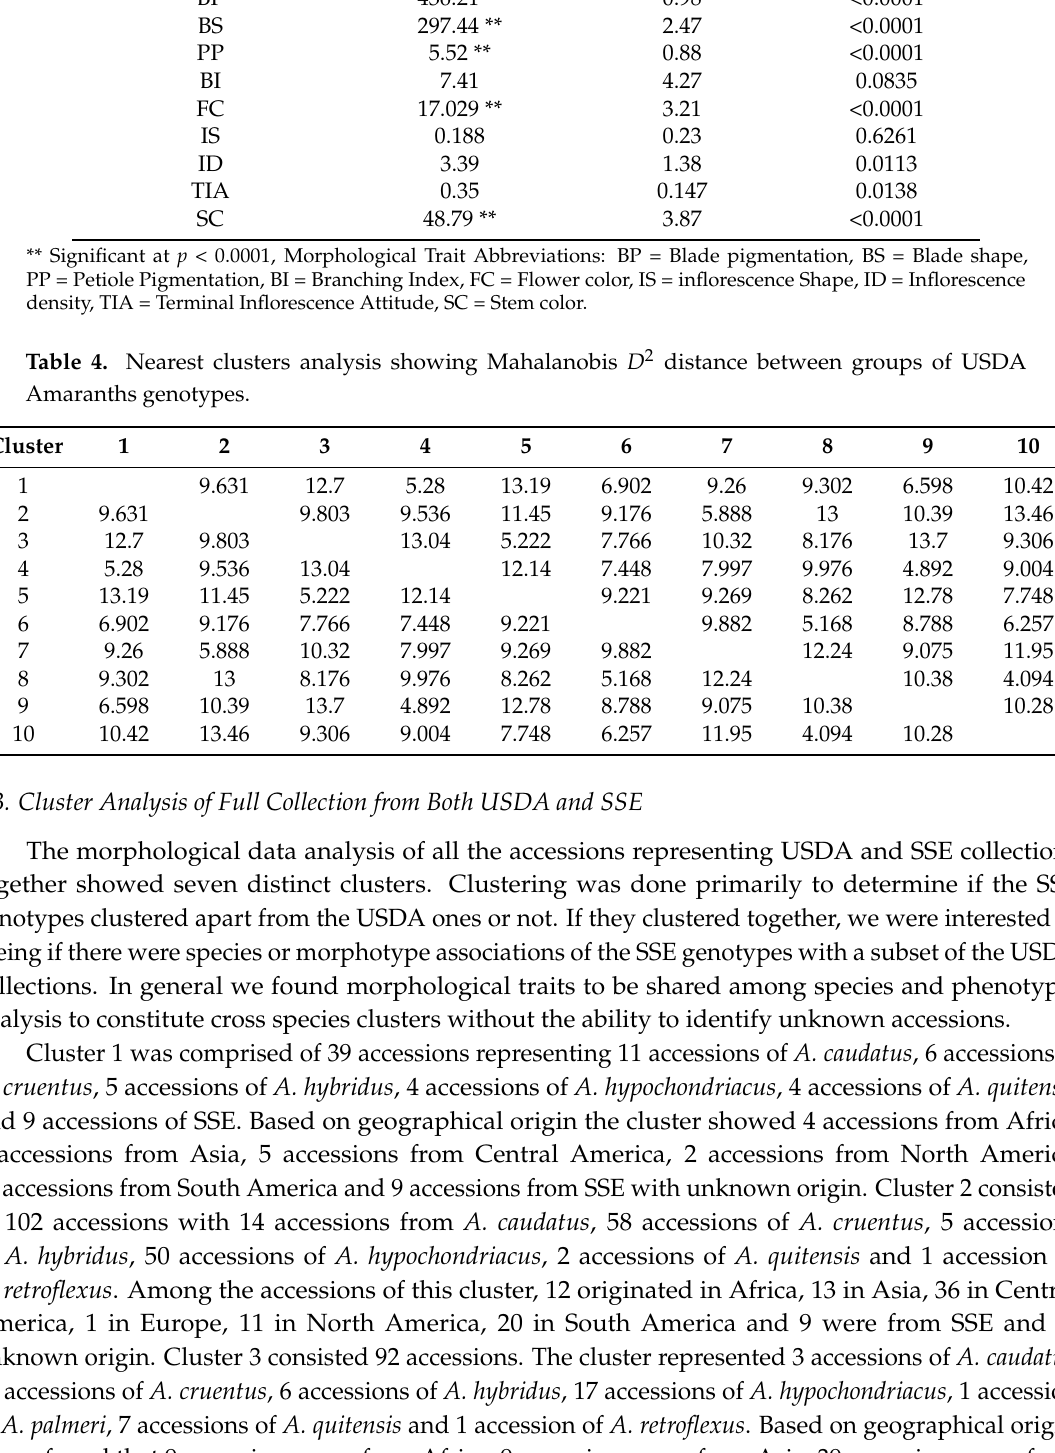
Table 3. Significance of morphological traits on different clusters of USDA accessions. Morphological Trait